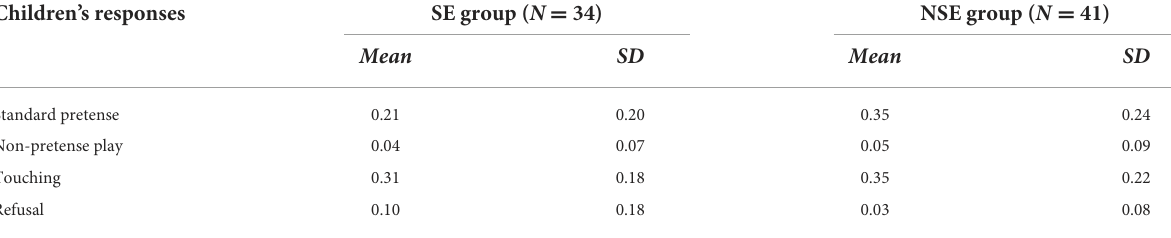
TABLE 2 Correlation between the proportions of standard pretense, non-pretense play, touching, and refusal. Dependent variables Standard pretense Non-pretense play Touching Refusal Standard pretense 0.05 − 0.40*** Non-pretense play − 0.04 − 0.05 Touching